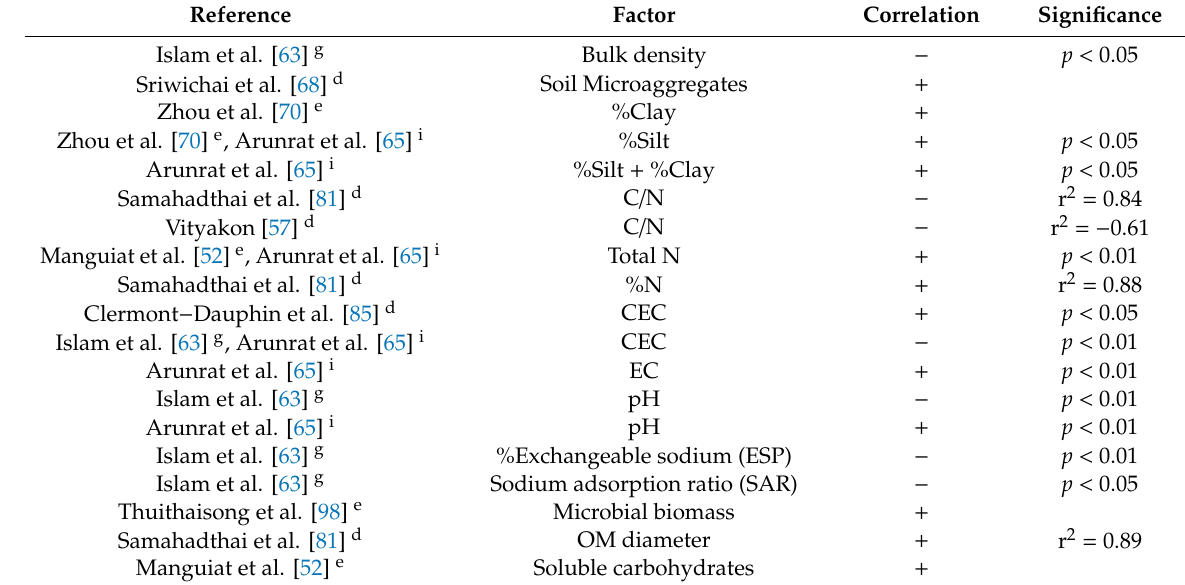
Table 2. Overview on correlation of soil organic carbon with soil physical and chemical properties under sandy soil conditions of Northeast Thailand (within the range of 0–40 cm